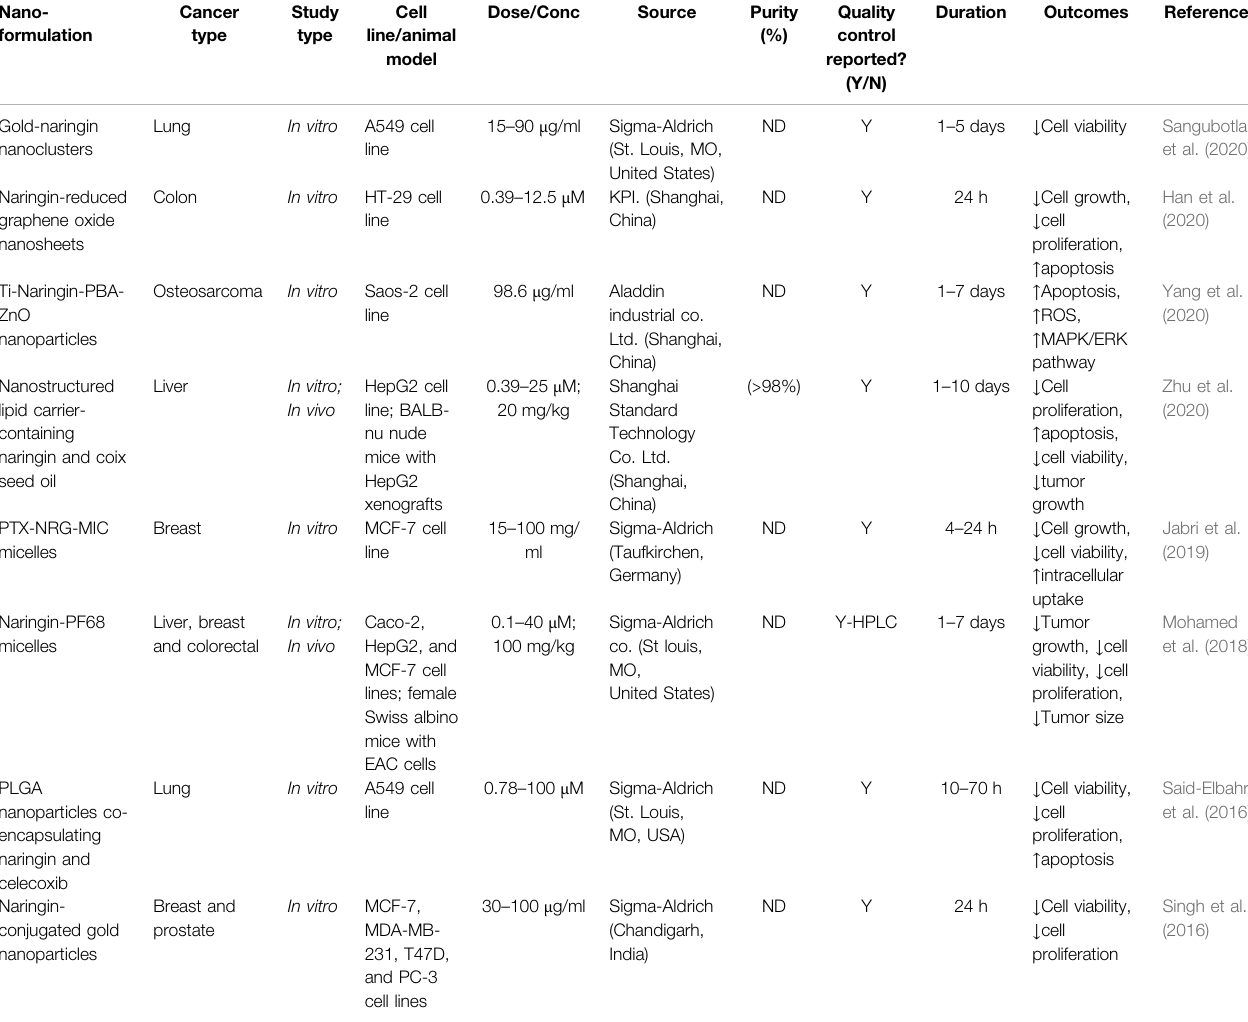
TABLE 5 | Anticancer effects of naringin-based nano-drug delivery